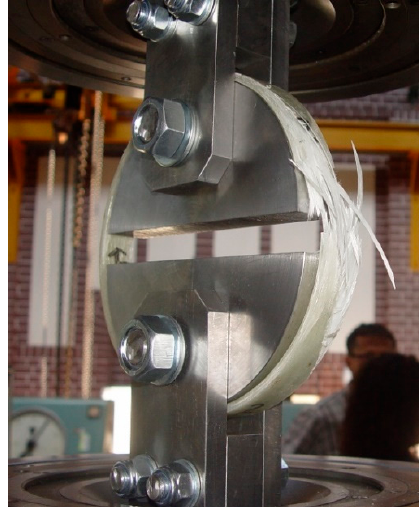
Figure 9. Ring sample of pipe with winding angle θ = 85° on the test stand after completion of experiment.